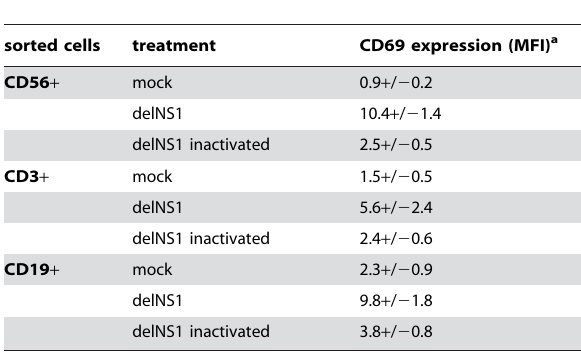
Table 1. CD69 expression of monocultures after virus